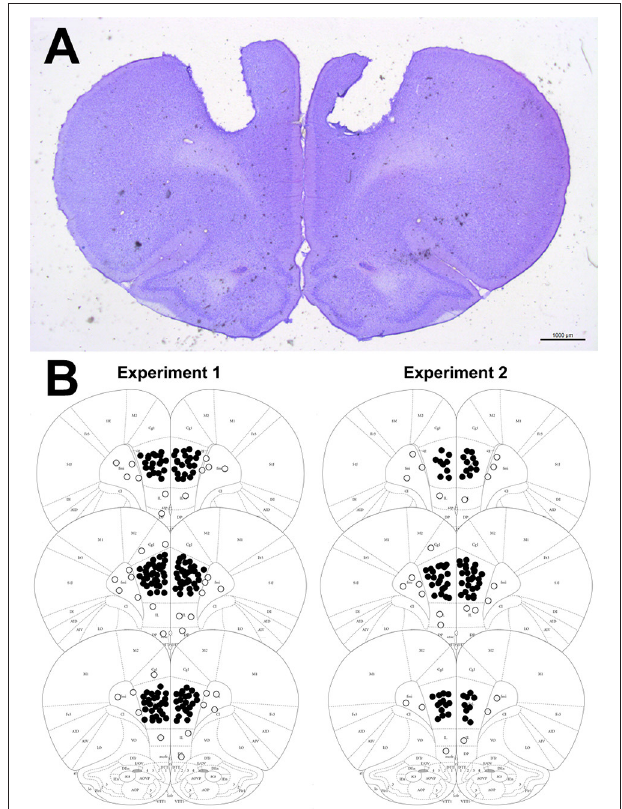
FIGURE 2 | (A) Representative photomicrography showing bilateral microinjection site into the PL-mPFC (coronal slices). (B) Diagrammatic representation of coronal brain sections (based on Paxinos and Watson, 2006) with representative injection sites into the PL-mPFC (filled circles) and adjacent sites (empty circles). The number of circles represented in the picture is fewer than the actual number of animals used in the experiments since there is